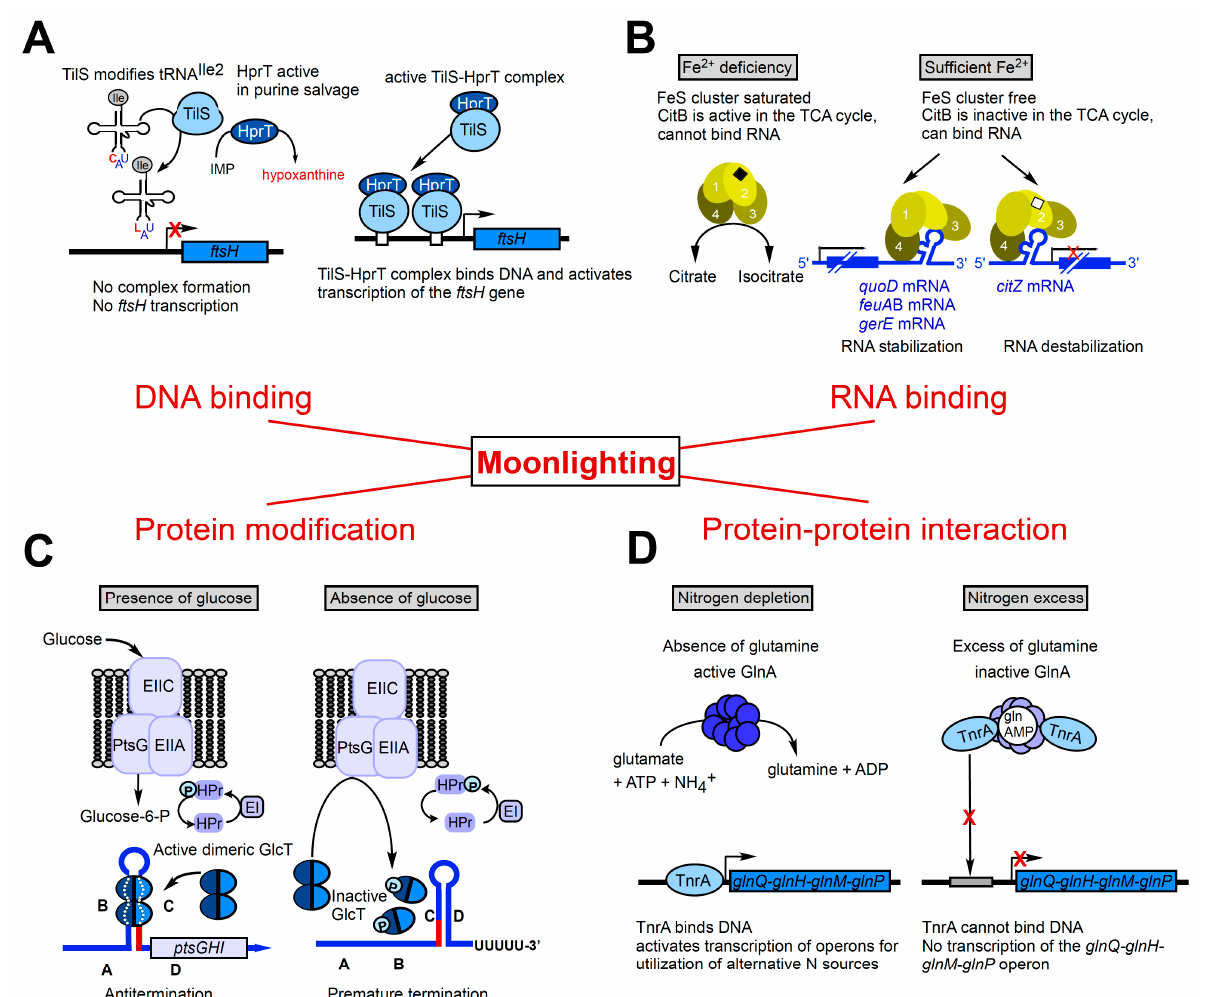
Figure 1. Examples of moonlighting proteins in B. subtilis that bind DNA, RNA or proteins or modify proteins. DNA is depicted as black lines, RNA as blue lines. Blue boxes, ORFs or operons; ovals or circles, proteins; arrows, transcription start sites; ( A ) the tRNA modifying enzyme TilS and phosphoribosyltransferase HprT can form a complex that binds DNA